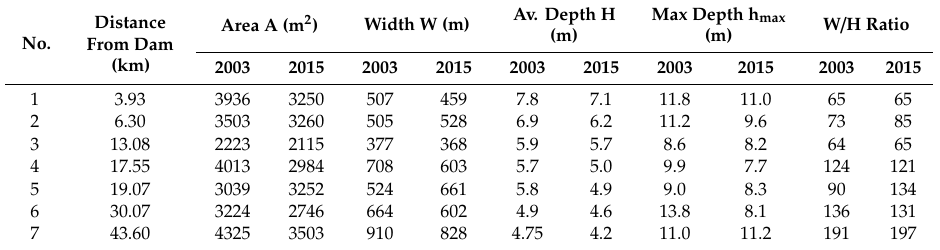
Table 1. Morphometric characteristics of seven cross-sections of the Dnieper channel downstream of the Kaniv